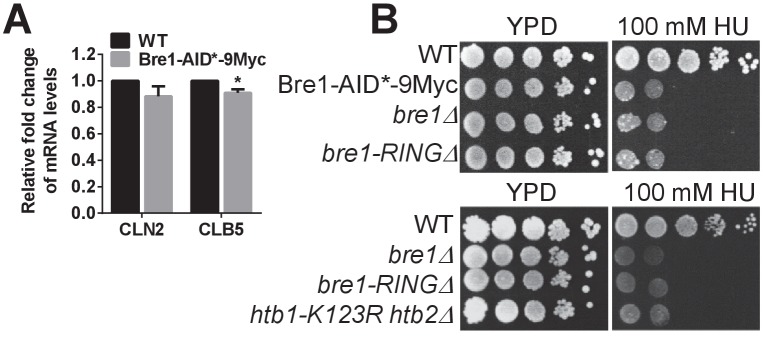
Characterization of Bre1-AID*−9Myc function.(A) Quantification of the mRNA levels of G1-S transition-specific transcripts CLN2 and CLB5 (Zimmermann et al., 2011) in wild-type (WT) and Bre1-AID*−9Myc strains by q-PCR. Three experiments were performed. Error bars represents SEM from three independent experiments. Statistical significance was analyzed by Student’s t-test. *p<0.05. (B) Hydroxyurea (HU) sensitivity of WT, Bre1-AID*−9Myc, bre1Δ, bre1-RINGΔ and htb1-K123R htb2∆ mutant strains at 100 mM HU. Bre1-AID*−9Myc is as sensitive as bre1Δ, and bre1-RINGΔ, suggesting that the -terminal AID*−9Myc tag may disrupt some of Bre1’s function in responding to replicative stress.